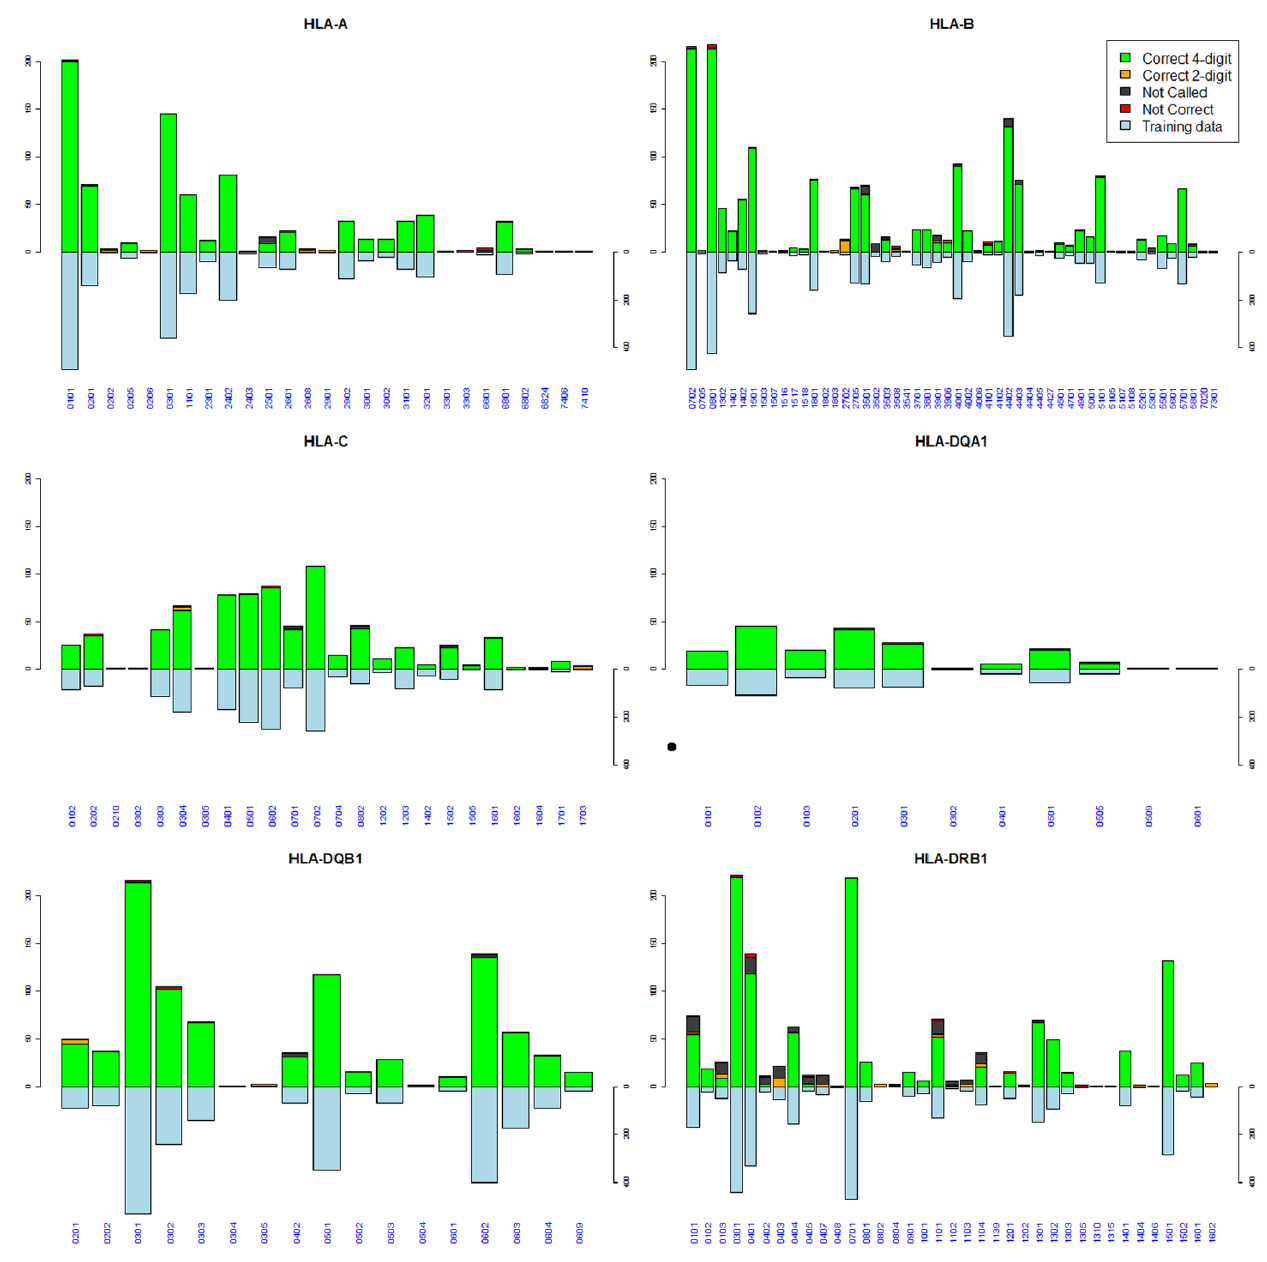
Figure 3. Per-allele accuracies on a diverse European reference panel (HLA*IMP:02). Per-allele analysis of HLA*IMP:02 imputation accuracy for six classical loci in the GS&HLARES_EU cross-European validation experiment at a call threshold of T=0.70. The x-axis represents the different HLA alleles in the validation panel. The downward blue bars indicate how often each allele appears in the reference panel (the GS&HLARES_EU 2/3 dataset). Imputation success is indicated by the upward stack plots: green indicates correct imputations at 4-digit HLA type resolution; orange indicates correct imputations at 2-digit resolution; black indicates alleles below the call threshold; red indicates incorrect imputations. Non-calls and imputations which are only correct at 2-digit resolution accumulate in the alleles which are rare or not present at all in the reference